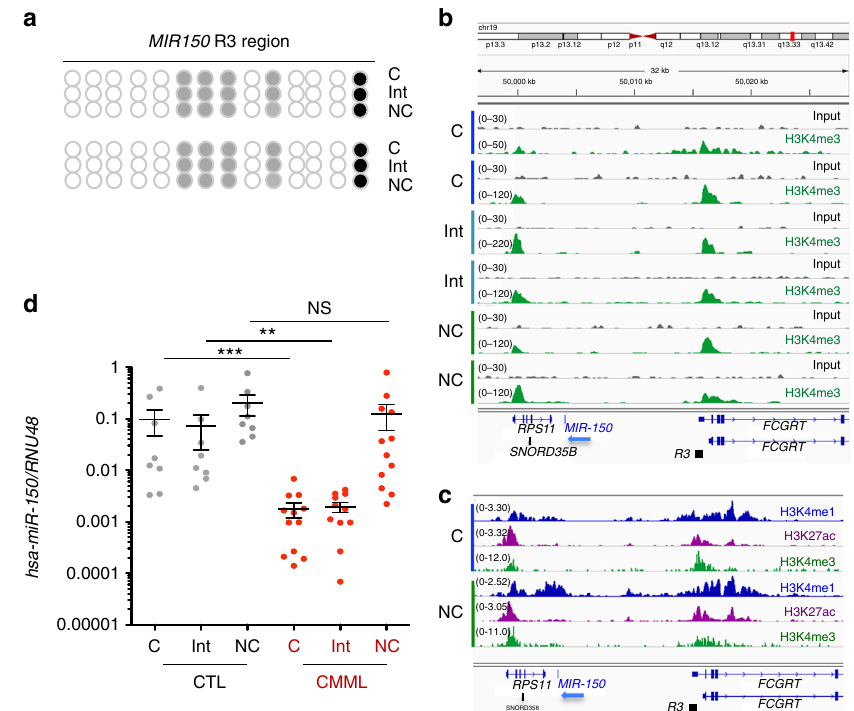
Fig. 7 Methylation of MIR150 region 3 in human monocytes subsets. a DNA methylation of MIR150 region 3 (R3) was analyzed in classical (C), intermediate (Int), and nonclassical (NC) monocytes sorted from healthy donor peripheral blood samples. (Results of two healthy donors are shown.) White ball: no methylation; gray ball: methylated on one strand; black ball: methylated on two strands. b . Input and ChIP-seq of H3K4me3 in sorted classical (C), intermediate (Int), and nonclassical (NC) monocytes collected from two healthy donors. Data are shown as normalized Bigwig. R3 region is representated. c ChIP-seq data for H3K4me1 (blue) and H3K27ac (purple) collected from ref. 42 and for H3K4me3 (green), conducted in human classical (C) and nonclassical (Non-C) monocytes. R3 region is representated. d qRT-PCR analysis of hsa-miR-150 expression normalized to RNU-48 in classical (C), intermediate (Int), and nonclassical (NC) monocytes sorted from peripheral blood samples of 8 healthy donor controls (CTL) and 12 CMML patients. Mean± SEM; Mann – Whitney test: ** P < 0.01; *** P < 0.01. NS nonsigni fi